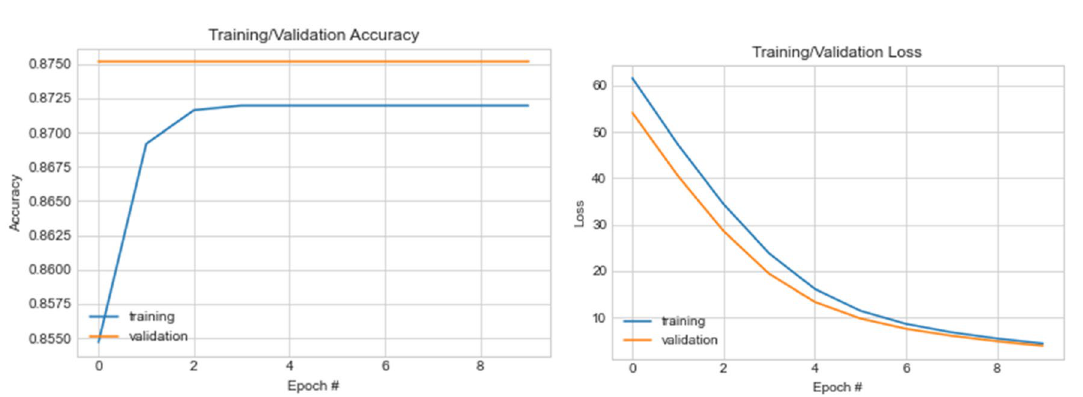
Figure 14. A graphical illustration of accuracy and loss value distribution for ten (10) epochs on the wavelet- CNN model using CLAHE